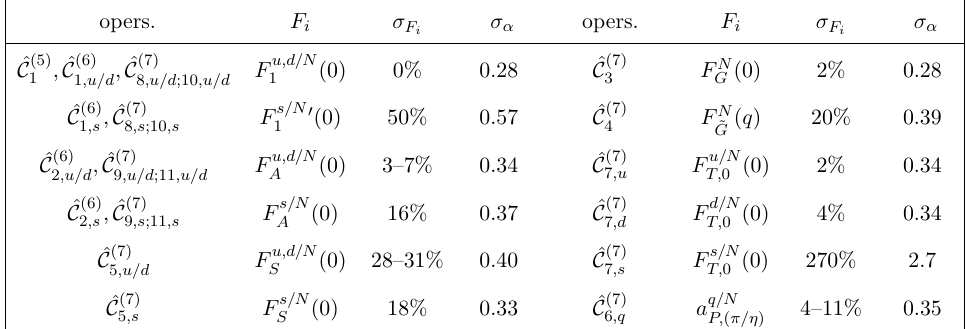
, and the resulting relative theoretical uncertainties on i ( d ) a (see the main text). Unless C